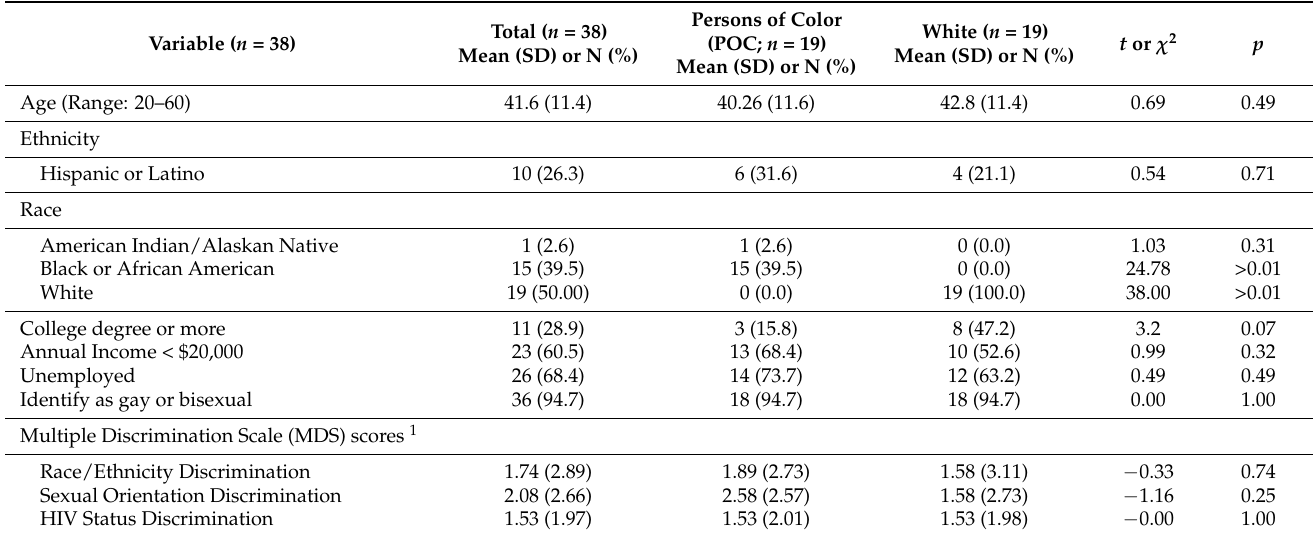
Table 1. Baseline characteristics of the sample (demographics and key variables).